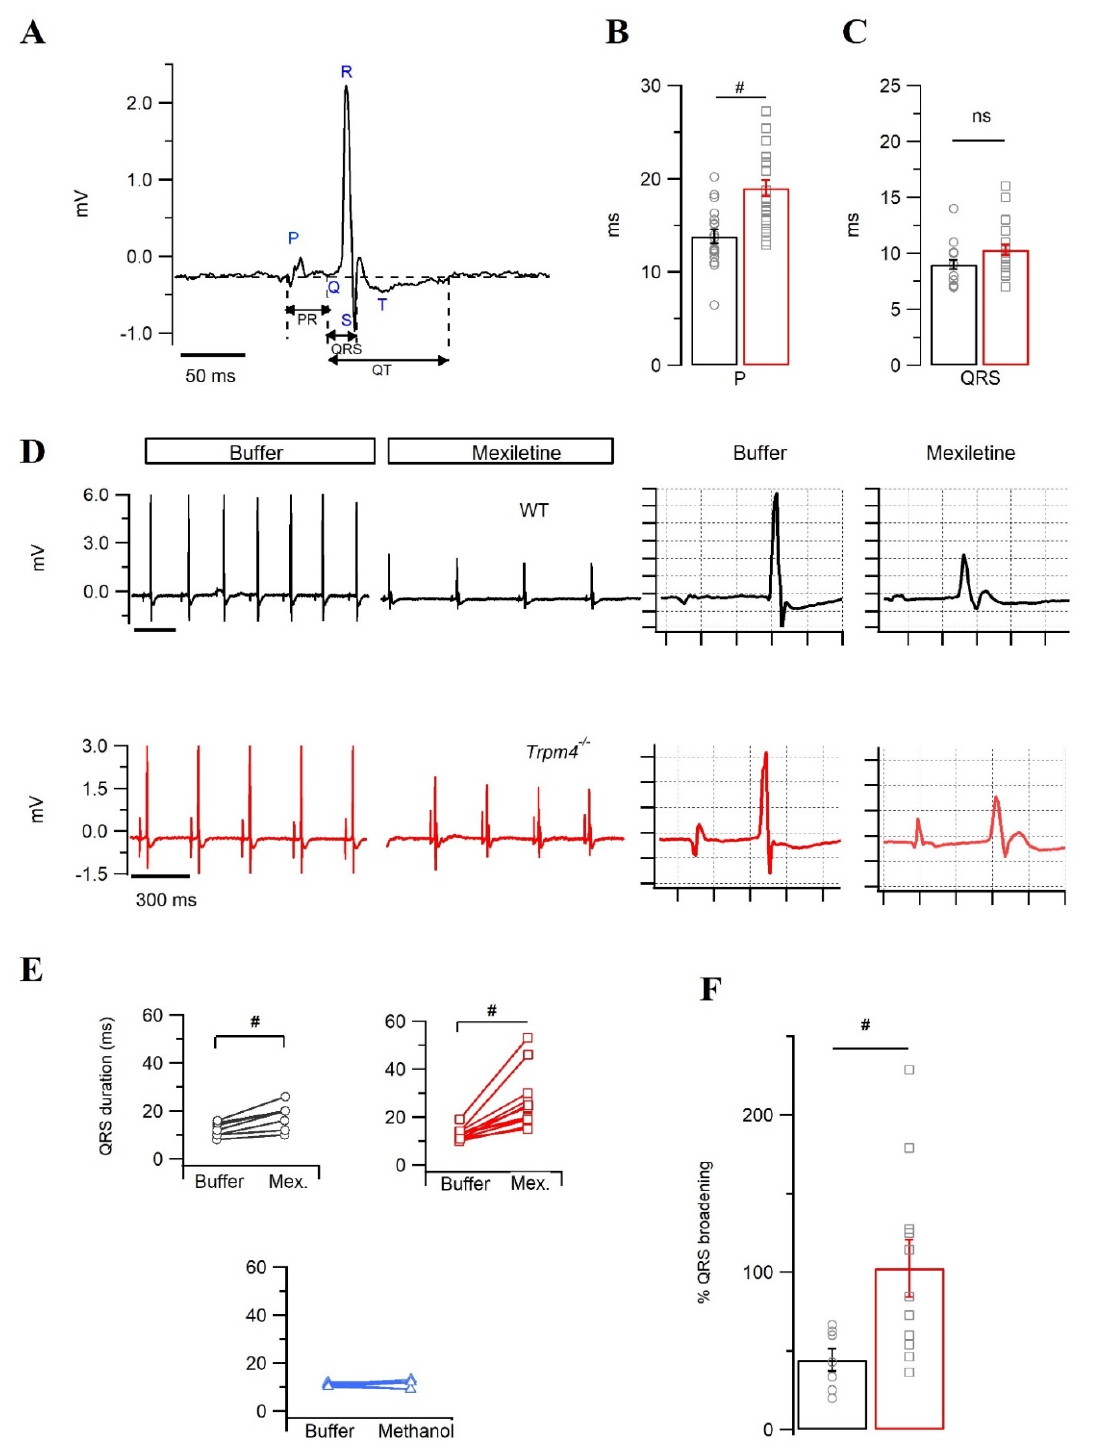
Figure 4. Pseudo-electrocardiogram recordings of WT and Trpm4 − / − explanted hearts. ( A ) Representative pseudo-ECG trace from WT heart highlighted for different ECG parameters, considered for further comparative studies. Average P ( B ) and QRS ( C ) durations recorded from either WT ( N = 19: circle, black) or Trpm4 − / − ( N = 22: square, red) hearts. ( D ) Representative ECG traces before and after perfusion with mexiletine. ( E ) QRS durations calculated when perfused with either buffer or mexiletine (Mex.) in WT ( N = 7, black) and Trpm4 − / − ( N = 11, red) mice or perfused with the vehicle control, methanol ( N = 6, blue). ( F ) The degree of broadening of QRS due to mexiletine perfusion compared between the genotypes as % inhibition (WT: circle, black and Trpm4 − / − : square, red). Note: #: p < 0.05, WT vs. Trpm4 − / − , ns- not significant.